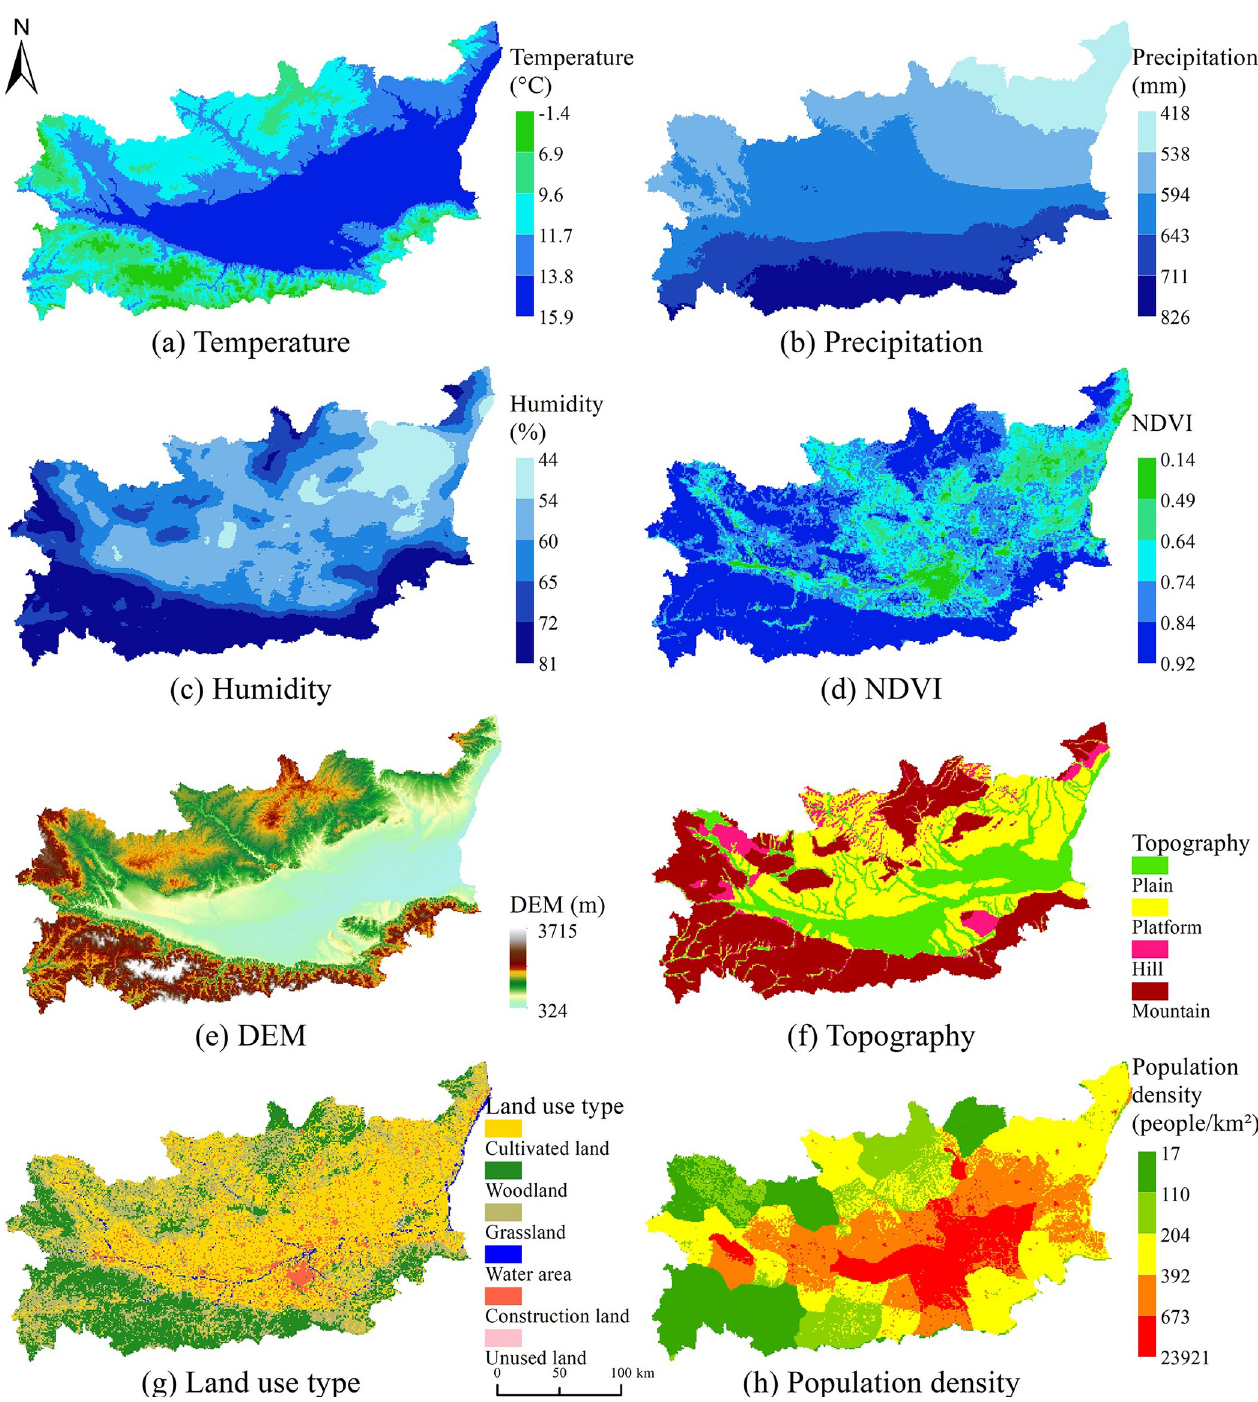
Fig 2. Spatial distributions of environmental and socio-economic factors in Weihe Basin of Shaanxi Province. https://www.resdc.cn/Datalist1.aspx? FieldTyepID=5,2.